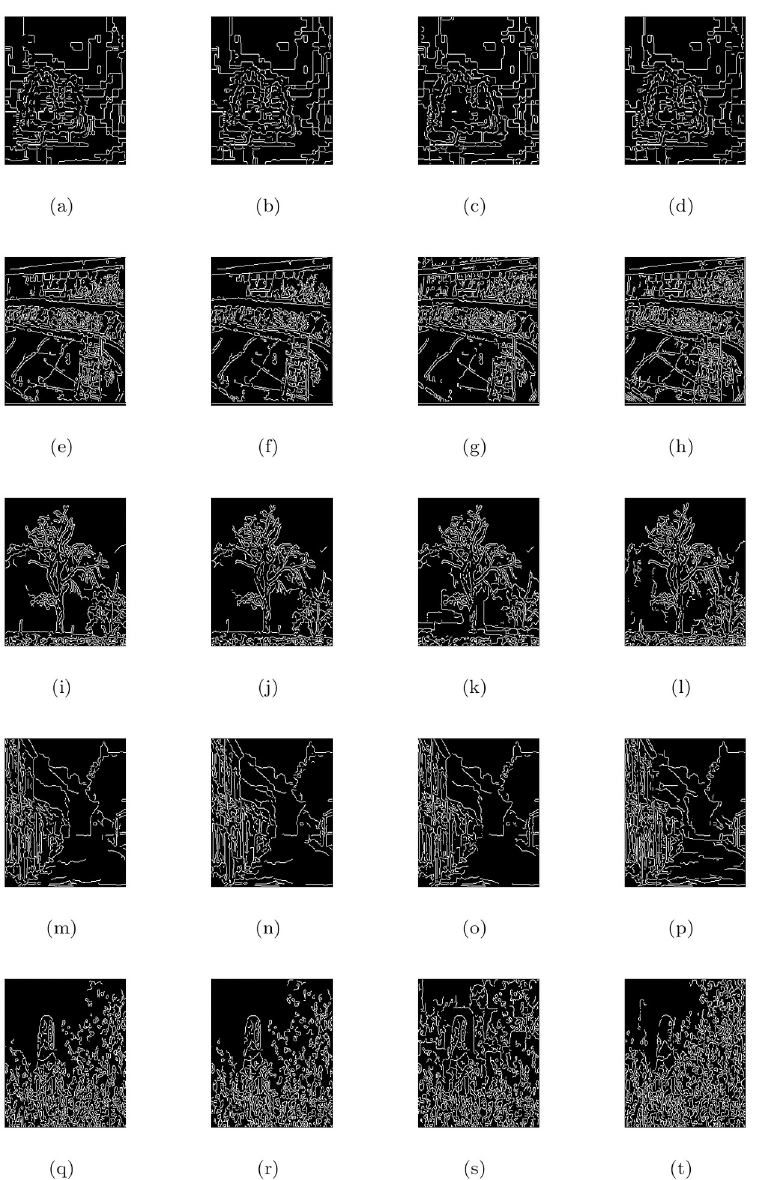
Fig 8. Corresponding visible edge maps of Fig